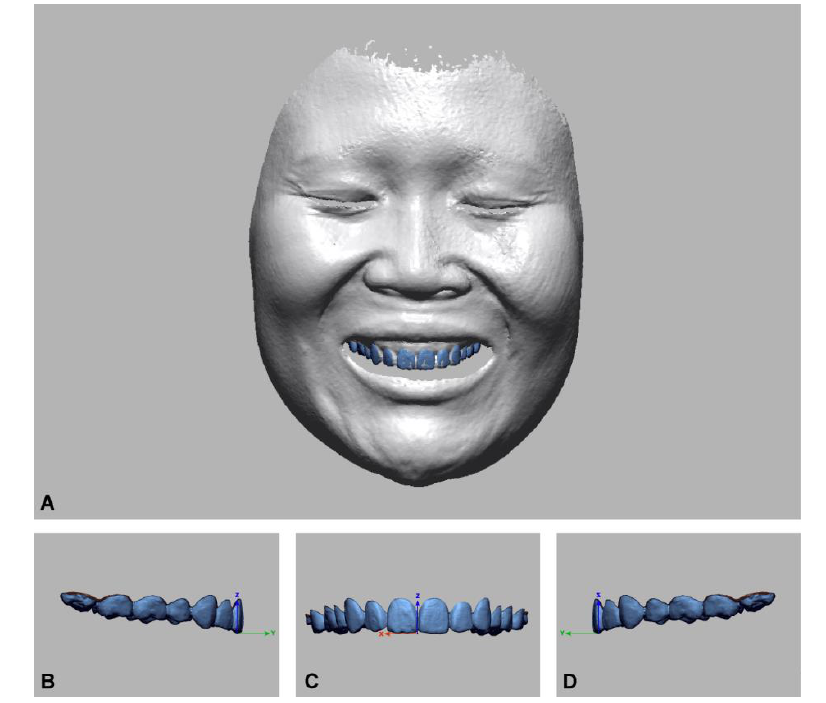
Figure 4. Construction of the reference image and the establishment of spatial coordinate system. ( A ) reference image; ( B ) left view of the coordinate system; ( C ) front view of the coordinate system; ( D ) right view of the coordinate system.